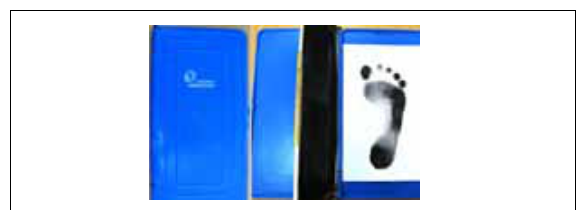
Figure 1. A Globus Berkemann plate